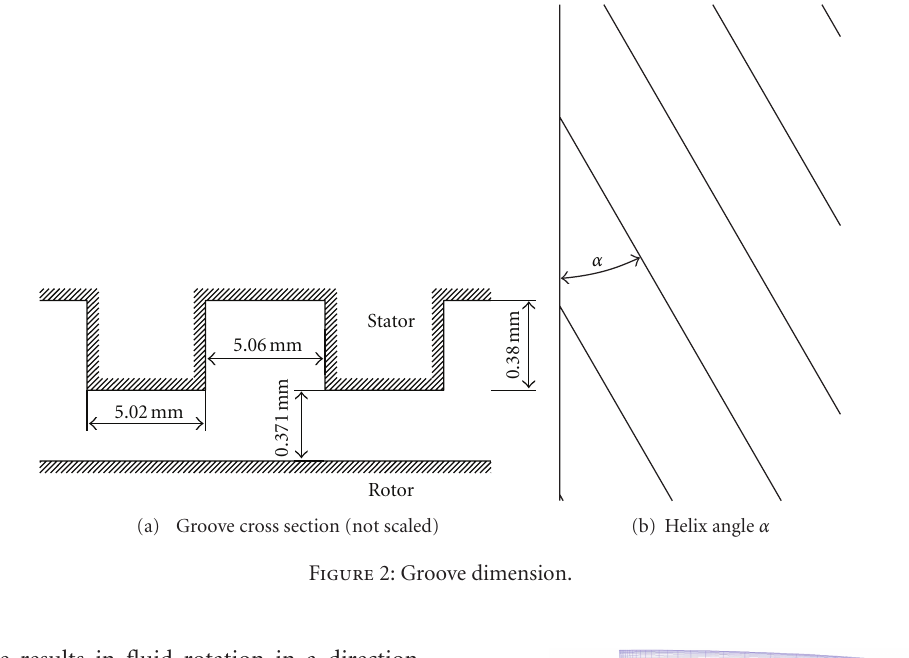
Figure 2: Groove dimension.